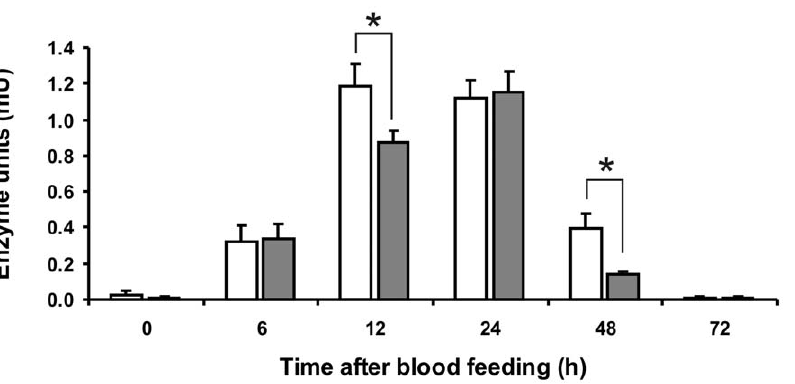
Figure 7. Enzymatic assay performed in solution with trypsin synthetic substrate BA r NA. Horizontal axis indicates insect midgut samples obtained at differenthours ABF.Vertical axis indicateenzyme unitsdetected per midgut. 0 : sugar-fed females; 6 to 72 : females obtained at 6, 12, 24,48 and 72 hours ABF. White bars indicate samples obtained from non infected insect midguts. Gray bars indicate samples obtained from infected insect midguts. Samples corresponding to half of one midgut were used in each assay. Statistically significant difference ( P , 0.05) is marked with an